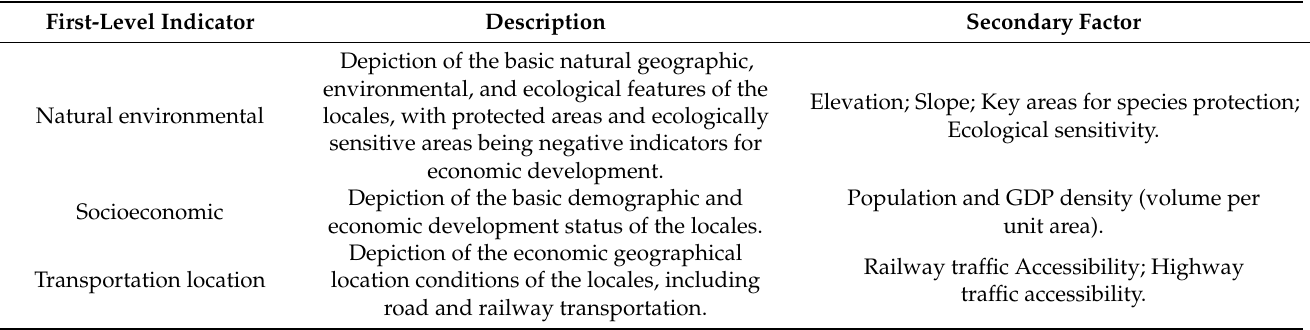
Table 1. The Rural Revitalization Factor Endowments Indicator